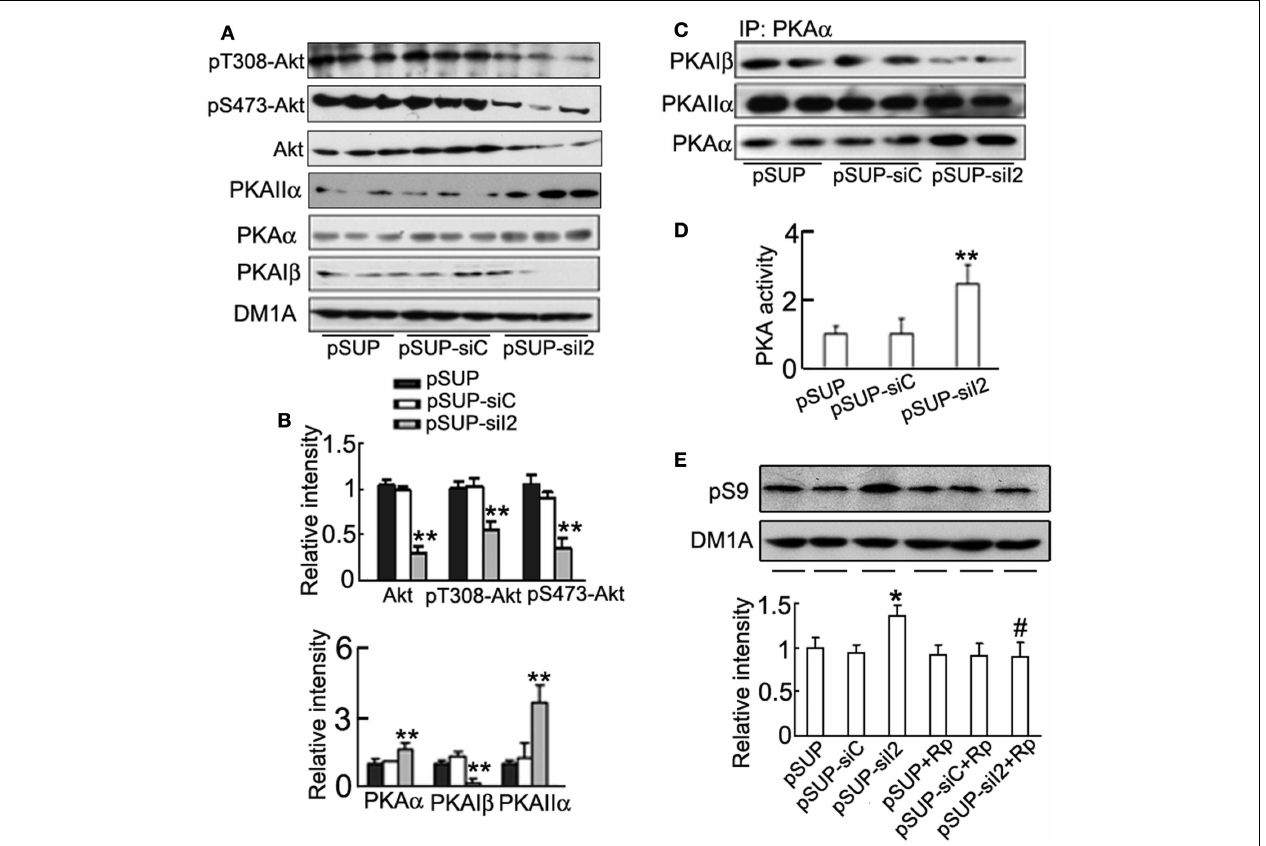
activity of PKA was also measured by a PKA assay kit as described in the FIGURE 8 |Activation of PKA is responsible for the phosphorylation of Section “Materials and Methods.” (E) The cells with overexpression of GSK-3 β at Ser9 induced by I PP2A knockdown . HEK293/tau cells were 2 pSUP-siI 2 , pSUP-siC, or the vector were treated with R p -cAMPS ( R p , 10 µ M) transfected with pSUP - siI PP2A (pSUP-siI 2 ) for 24h, and pSUP and pSUP-siC 2 for 30min, and then pS9-GSK-3 β was detected byWestern blotting and were expressed as the controls. (A,B) The levels of phosphorylated Akt at quantitative analysis.The relative intensity was normalized against DM1A and Thr308, Ser 473, total Akt, PKA α , PKAII α , and PKAI β were estimated by Western blotting (A) and quantitative analysis (B) . (C) The cell lysates were expressed by setting pSUP as 1.The data were presented as mean ± SD of three independent experiments. * p < 0.05;** p < 0.01 vs. pSUP; # p < 0.05 vs. subjected to immunoprecipitation (IP) with anti-PKA α antibody, and the pSUP-siI 2 precipitates were probed by anti-PKA α , anti-PKAI β , or anti-PKAII α . (D) The